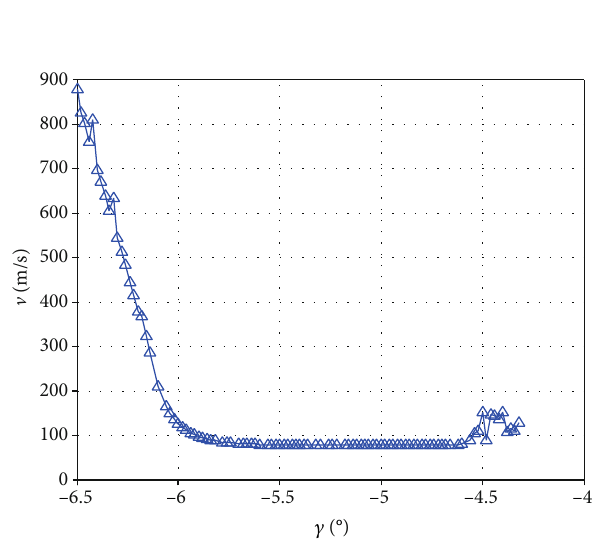
Figure 14: Variation in velocity increment with reentry angle.